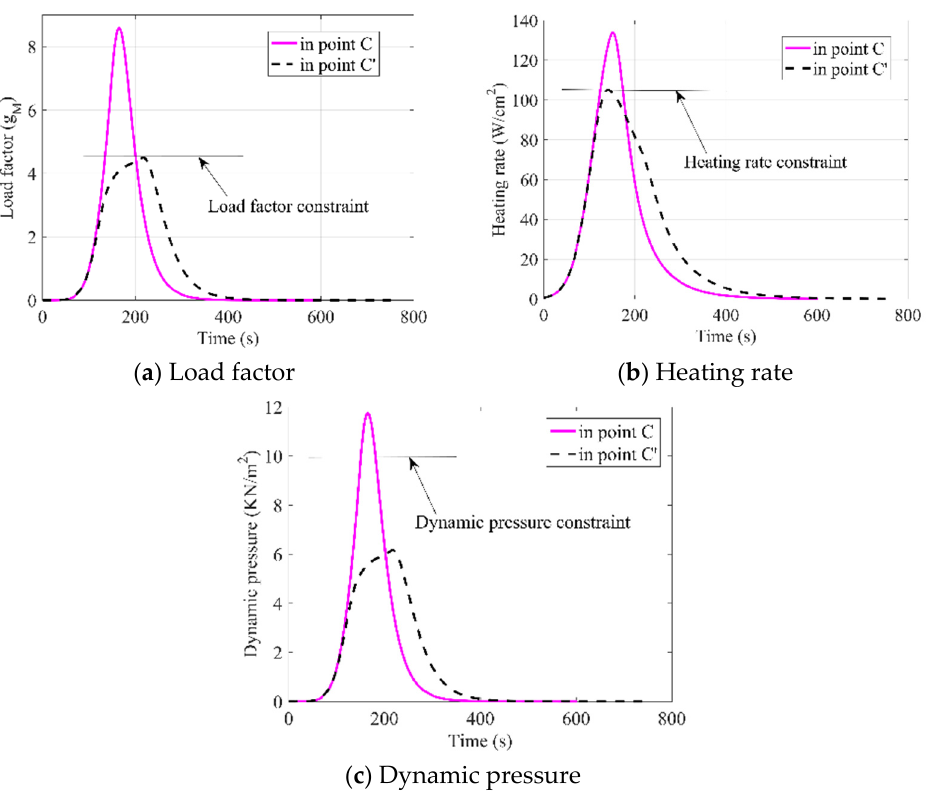
Figure 15. Load factor, heating rate, and dynamic pressure profiles corresponding to points C and C ′ in Figure 13.